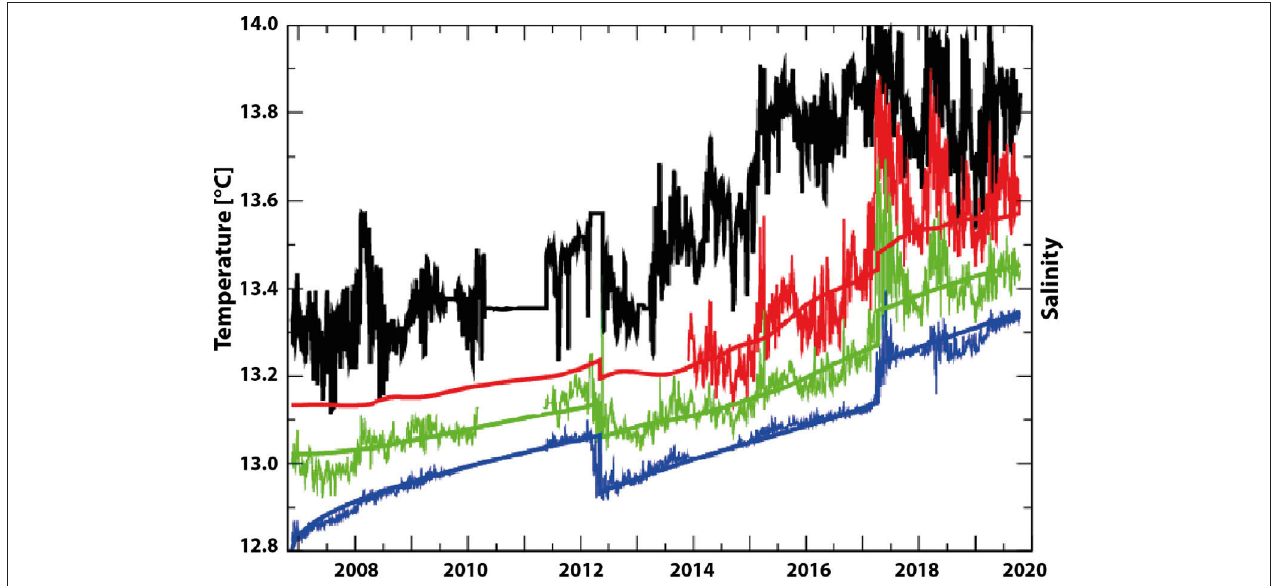
FIGURE 4 | The observational data (thin lines) and the corresponding solutions of the injection-diffusion model (thick lines) for different depths (black 750 m, red 900 m, green 1,000 m, blue 1,200 m) for temperature.